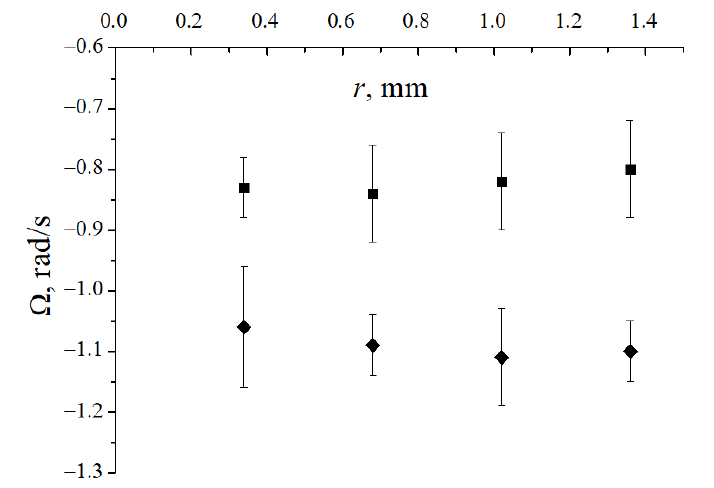
Figure 6. Dependence of the angular velocity of dust particles on the radius r at p = 0.5 Torr, h = 10 mm. Squares: striation VI, I = 1.2 mA, B = 269 G; rhombs: striation VII, I = 1.3 mA, B = 350